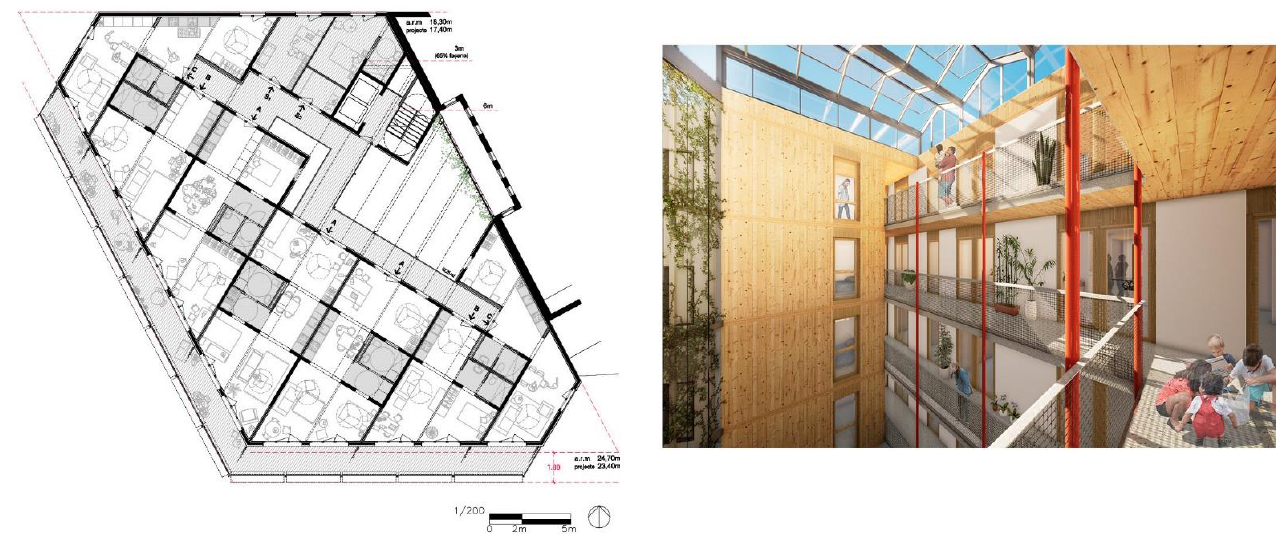
Figure 8. Sotrac housing cooperative by Lacol. Typical plan of the competition proposal and rendered view of the courtyard. The circulation is arranged around a courtyard covered by a “greenhouse” roof. The dwellings are oriented towards the sun and Can Batlló. Two additional rooms for sharing are located to the north, next to the circulation core. Source: Courtesy of Lacol.